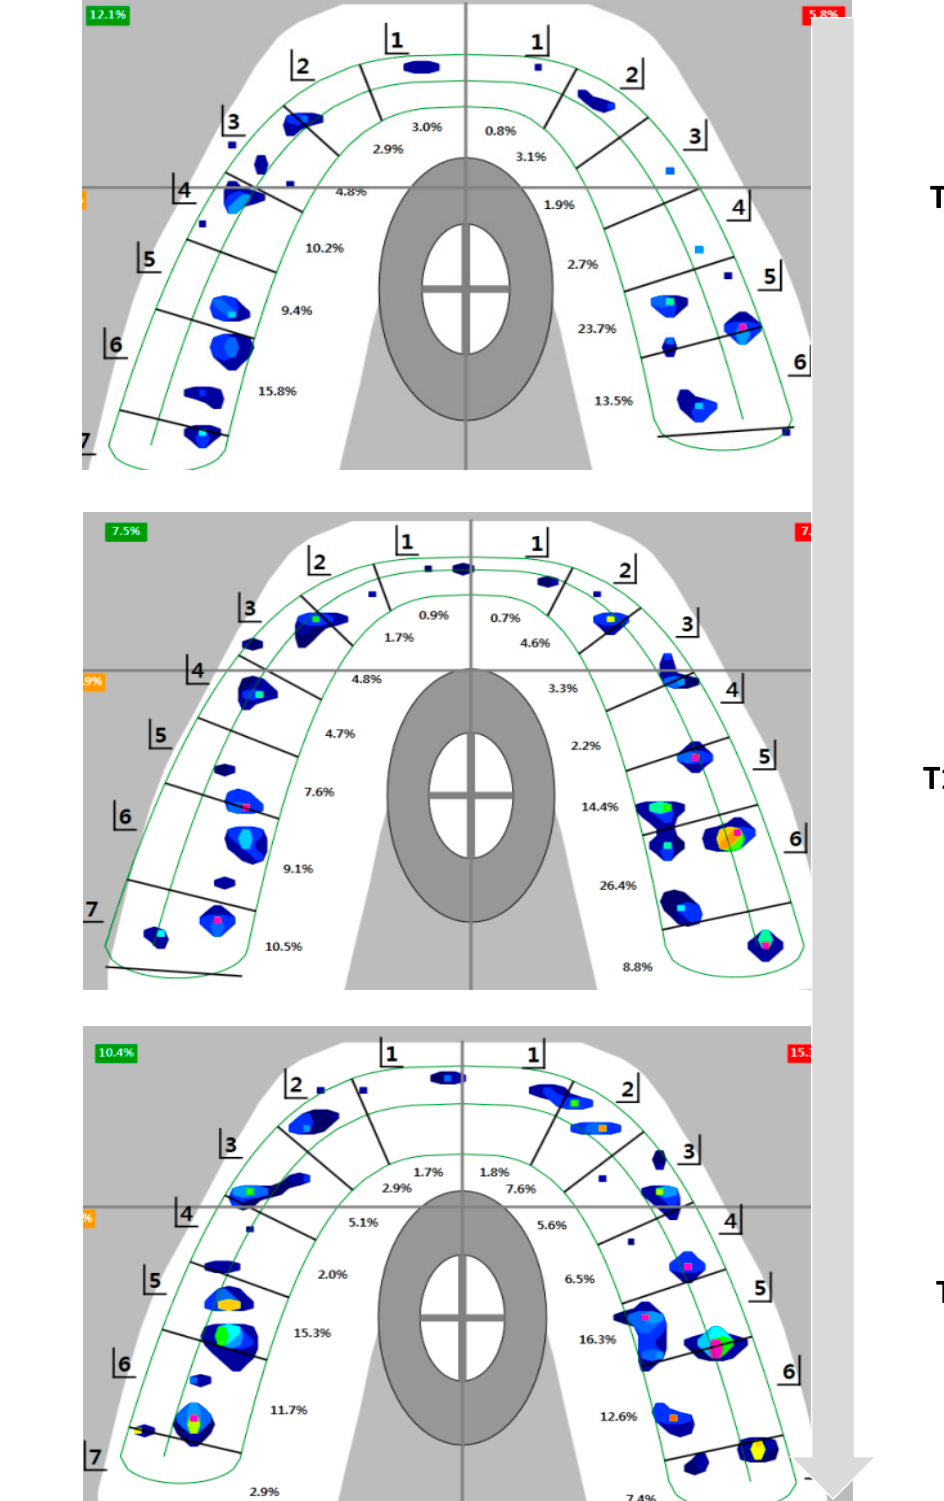
Figure 6. Flow of occlusal contact view during T0 to T2 in T-scan system. The data were analyzed by calculating the total force per bite registration and determining the percentage of force by quadrant (total 100%) for each centric occlusion bite at MICP. ( a ) T0, at debonding. ( b ) T1, one month after retainer delivery. ( c ) T2, four months after retainer delivery.